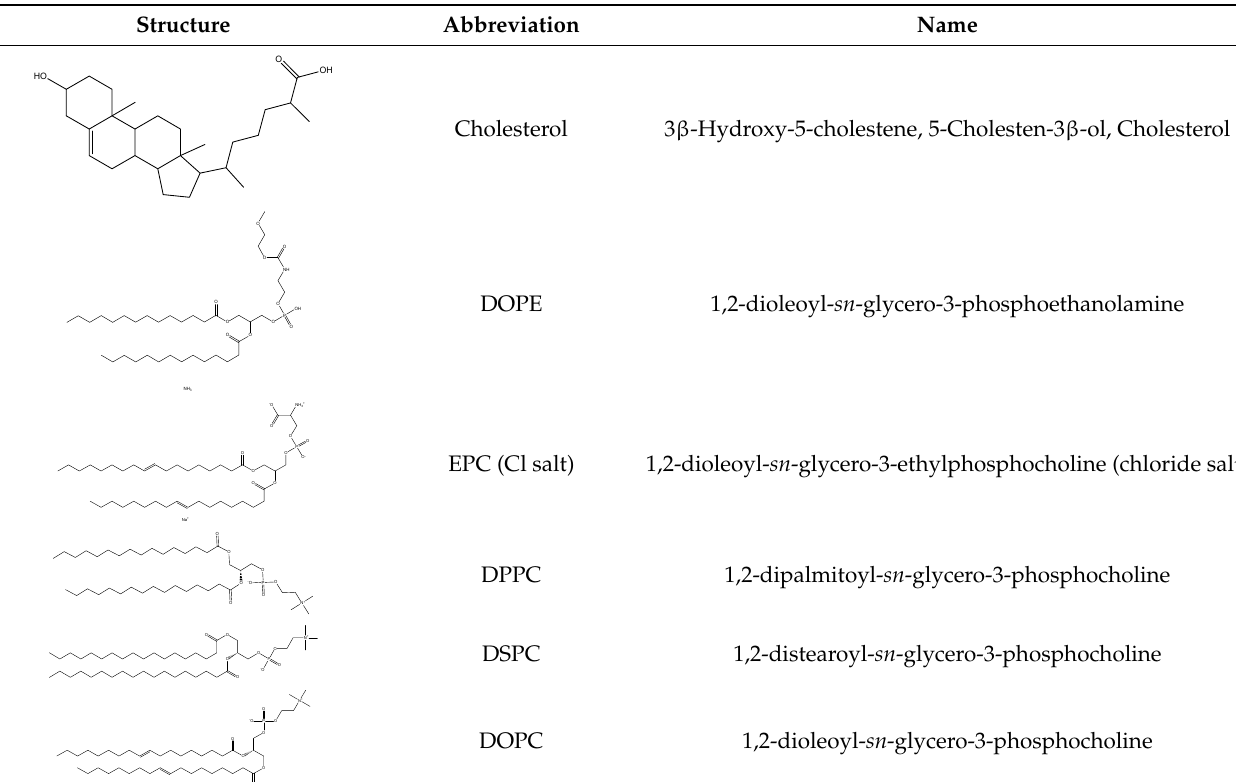
Table 7. Types of common neutral lipids used in formulating neutral liposomes for drug and gene delivery.